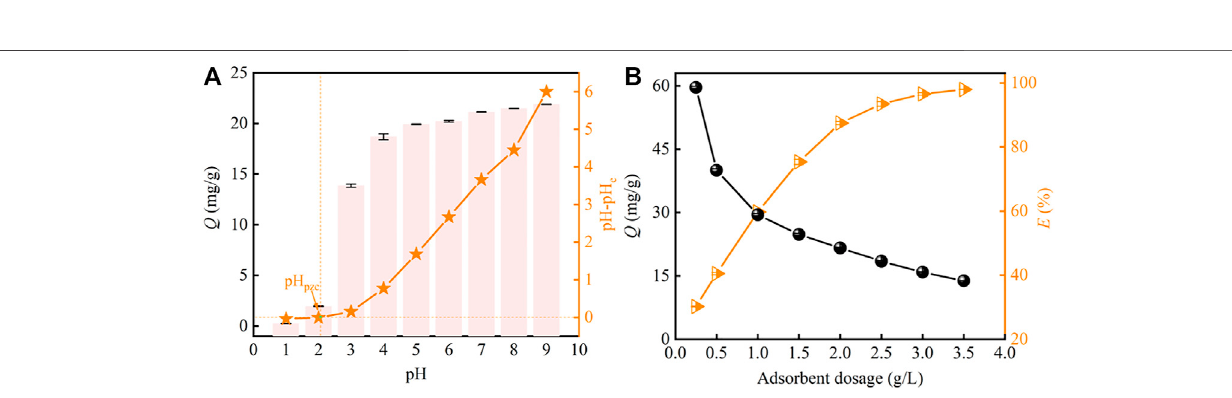
FIGURE 3 | (A) Effect of pH on Sr(II) adsorption ( C o : 50 ppm, m / v : 2 g/L, T : 298 K, t : 3 h, r : 120 rpm). (B) effect of adsorbent dosage on Sr(II) adsorption ( C o : 50 ppm, pH: 8, T : 298 K, t : 3 h, r : 120